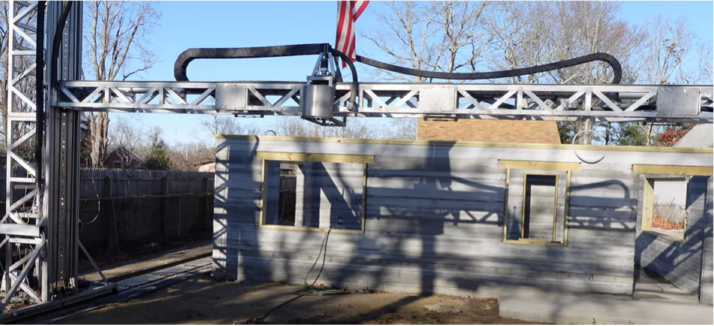
Figure 12. SQ4D arcs printer [35]. Reprinted with permission from Ref. [35]. 2021, Jarett Gross.